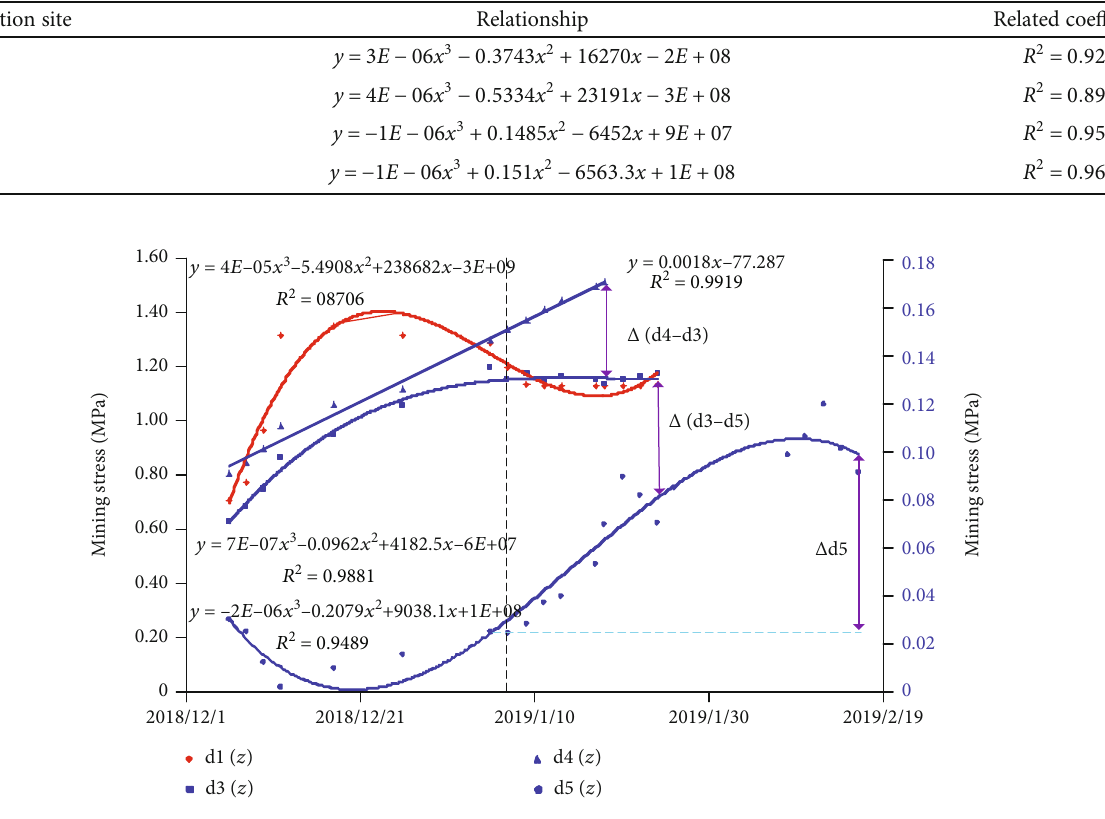
Figure 14: Monitored mining stresses along